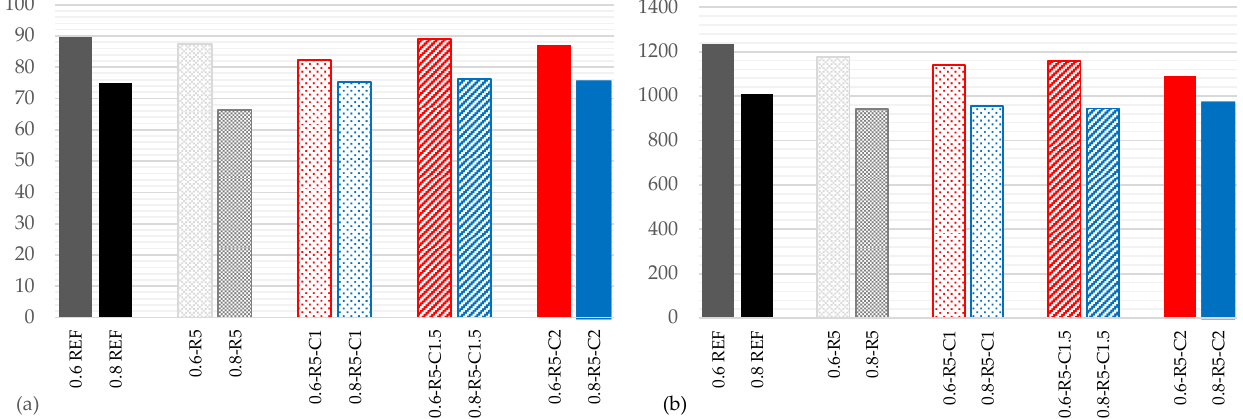
Figure 3. Results for Shore C hardness ( a ) and densities in Kg/m 3 ( b ). The incorporation of carbon fibers offsets the decrease in Shore C hardness caused by the inclusion of rubber. The differences in values are not considered to be relevant in any of the